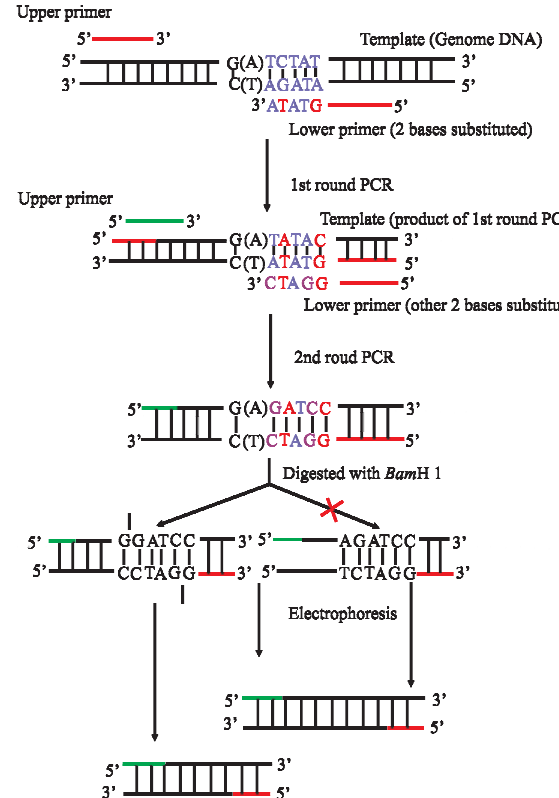
Figure 1 - Schematic of the method described in this article. The SNP usedasanexampleisaGtoAsubstitutionintheCYP3A4gene.Aftertwo roundsofamplificationwithmismatchedprimersthesequencearoundthe SNP locus is changed and a RER site is introduced into the product of one genotype only. The ‘G’ genotypes with can be digested with Bam H I but the ‘A’ genotype cannot, so the two genotypes can be distinguished using agarose gel